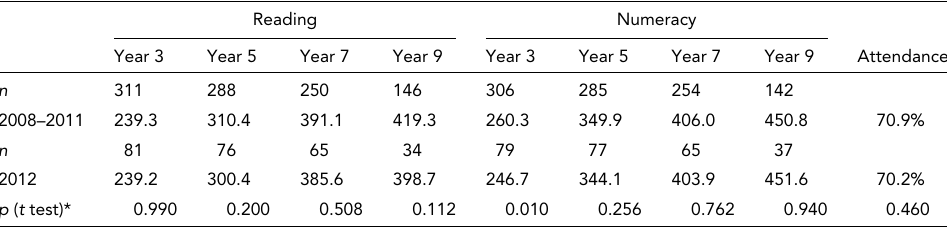
NAPLAN Results for Very Remote Schools With Greater Than 80% Aboriginal and Torres Strait Islander Student Population (2012) Reading